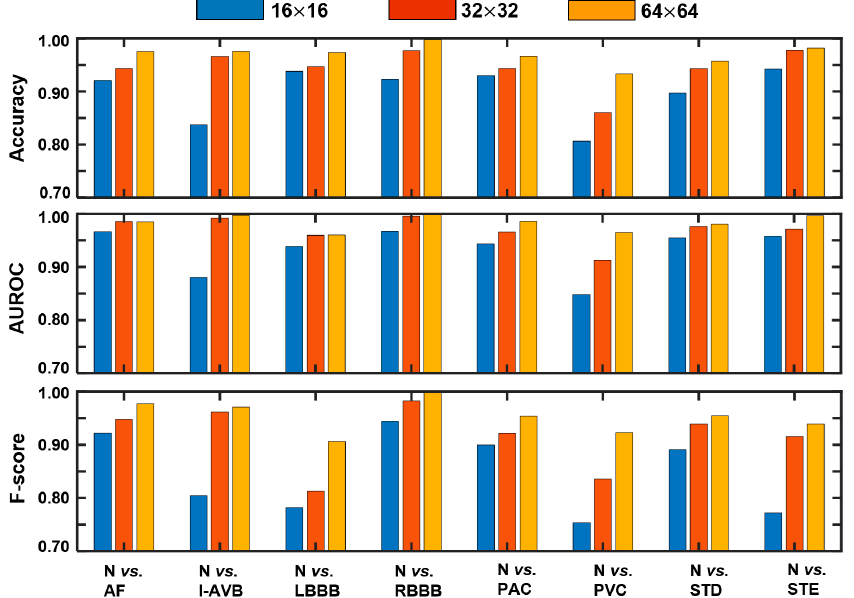
Figure 4. Performances of the proposed framework with varying size of the GADF image, i.e., 16 × 16, 32 × 32, and 64 × 64. Table 2. Performance Comparison with Benchmark Approaches in Category 1. N